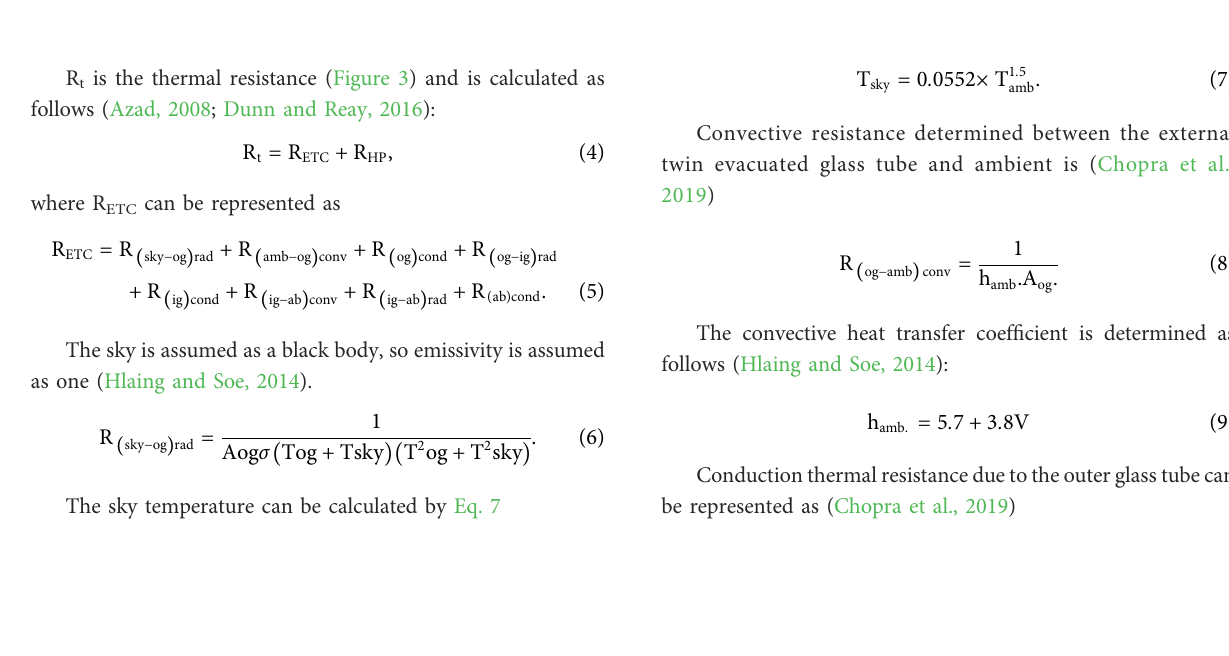
FIGURE 2 Graphic representation of the ETSC-CCHPSD